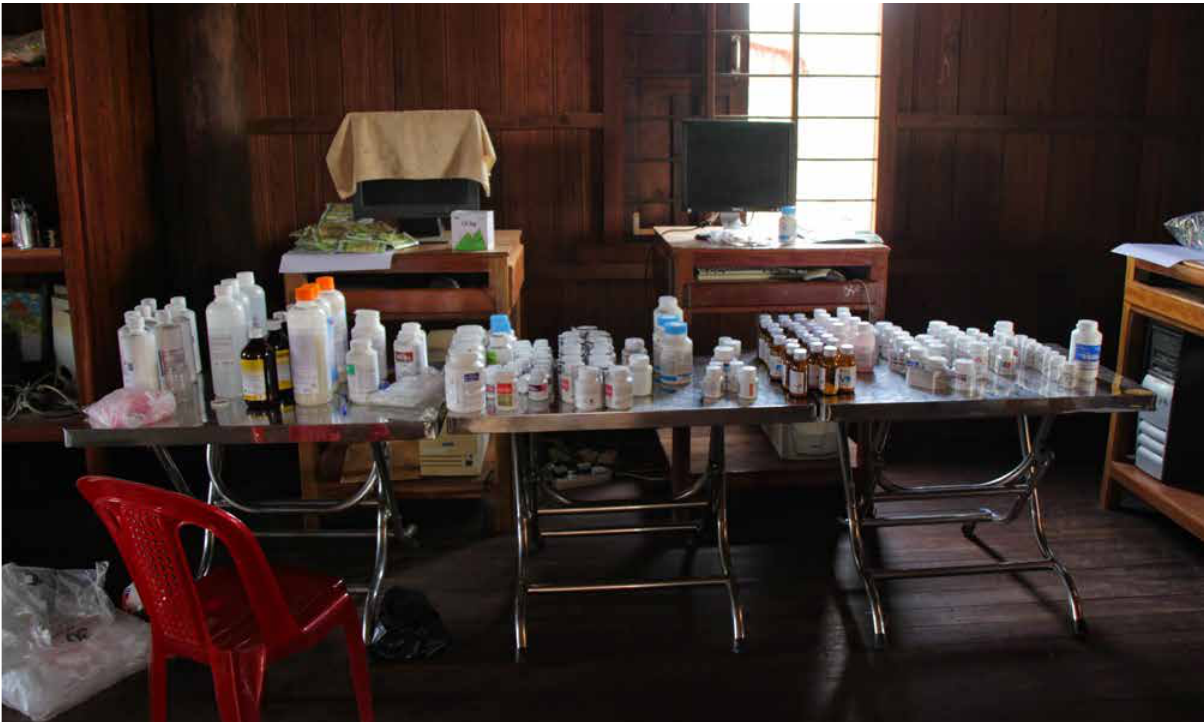
Figure 1: Medical station in